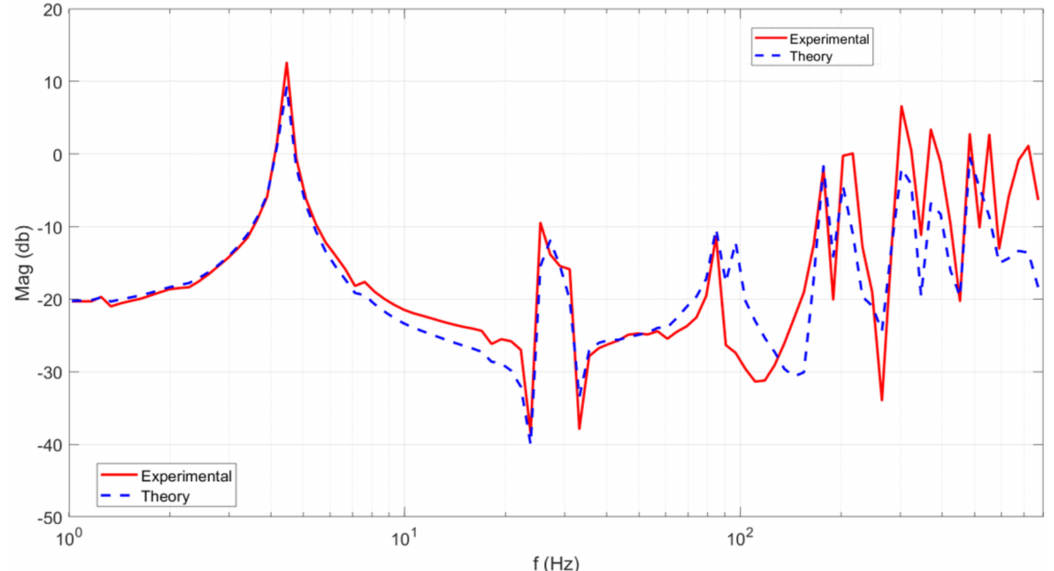
Figure 4. Comparison of frequency response function magnitude of the partially submerged plate (H = 0.3 m), theory and